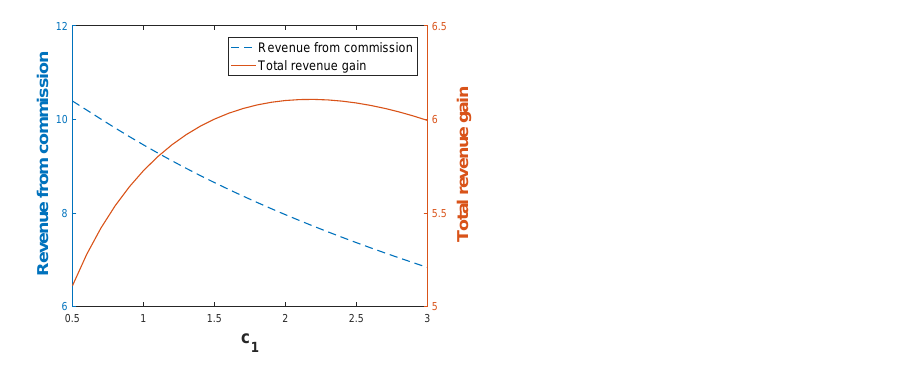
Figure 4. The impact of c 1 when µ 2 < µ 2 . Total revenue gain: π ∗ s ∗ λ ∗ . ( α = β = 0.5, V 1 = V 2 = 2.5, c 2 = 0.5, µ 1 = 10, µ 2 = 15, Λ 2 = 3, Λ 1 = 12.) 12